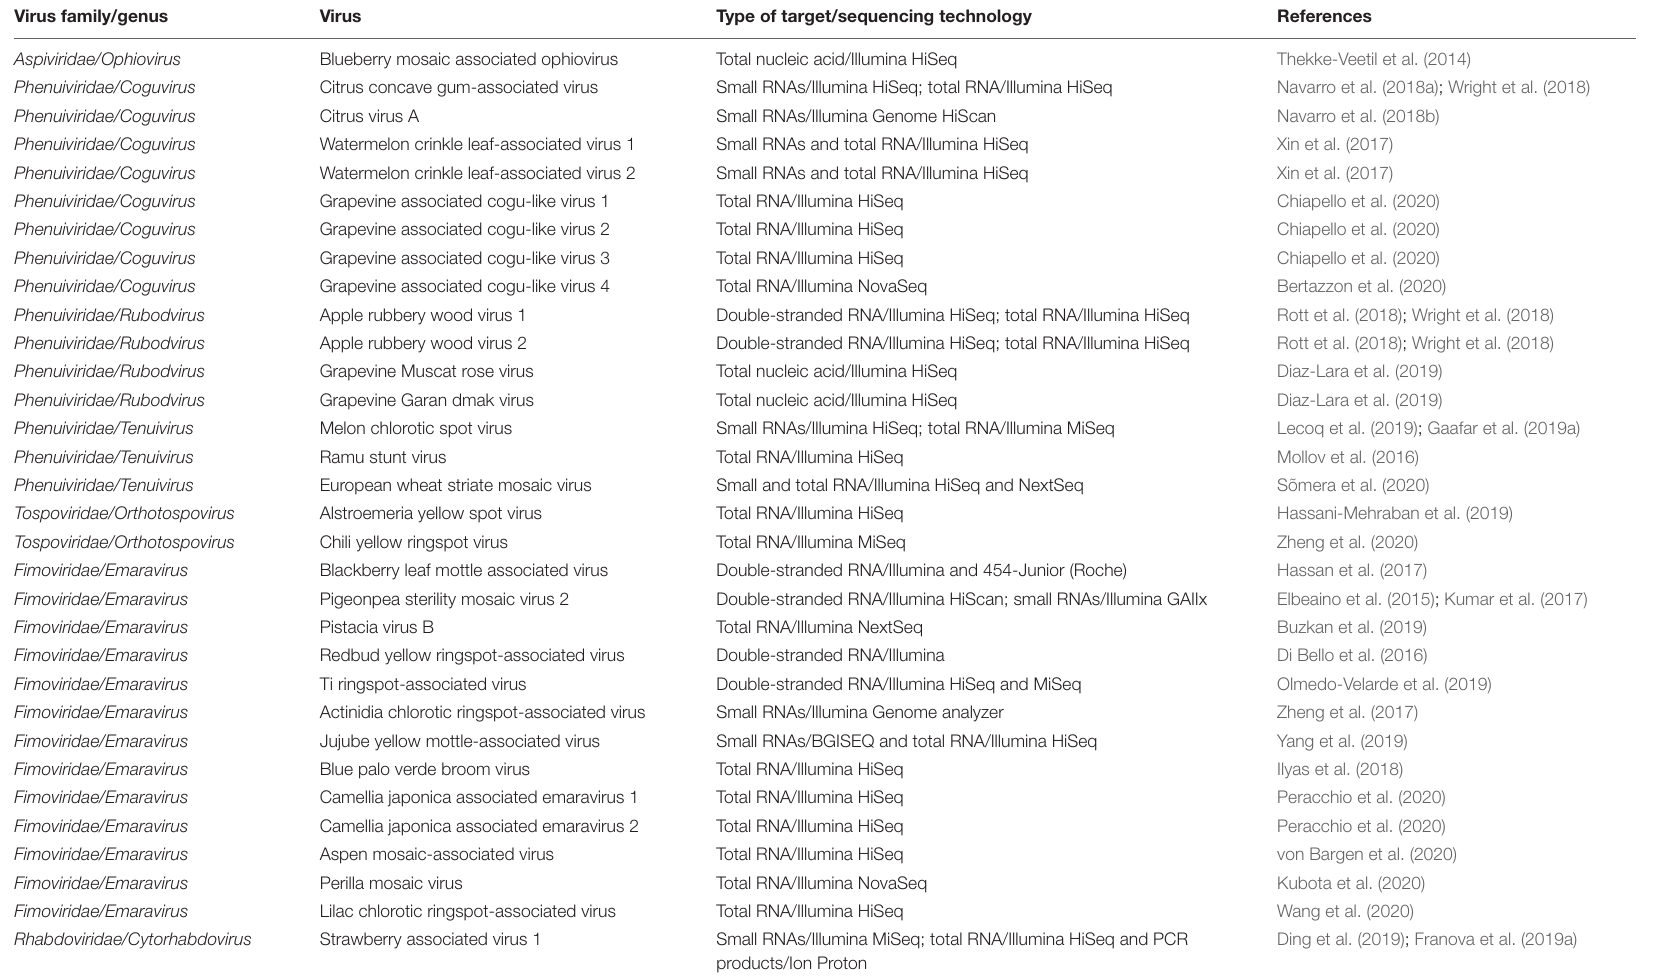
TABLE 1 | Novel NSR viruses discovered using